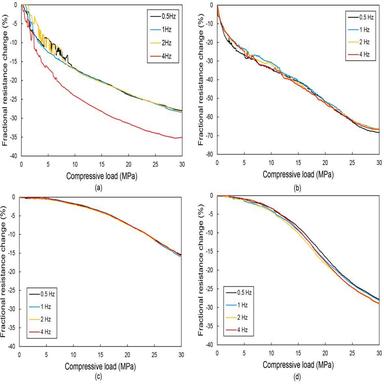
Fractional resistance change of the samples with TWCNT content of (a) 0.1, (b) 0.2, (c) 0.3, and (d) 0.5% under the monotonic compressive loadings with various loading frequencies.